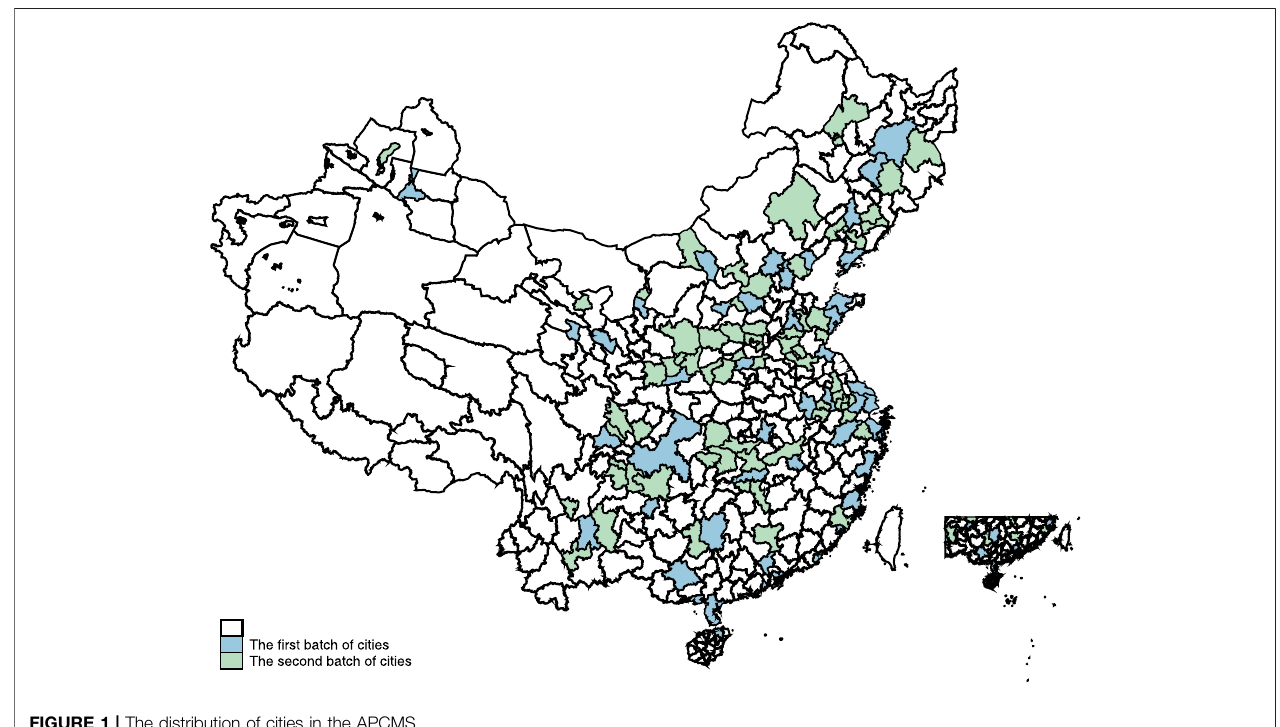
FIGURE 1 | The distribution of cities in the